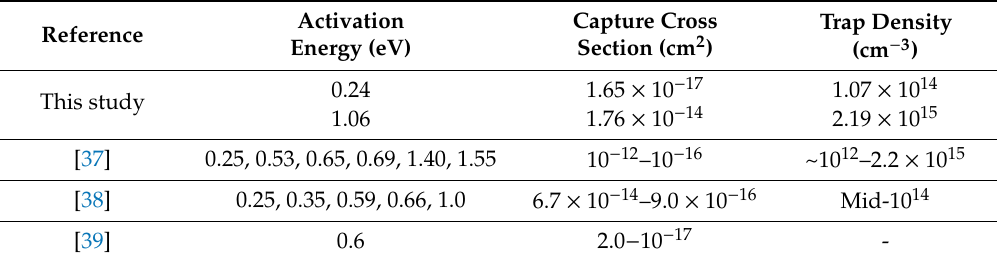
Figure 4. The DLTS spectra of Pd / Si-based GaN crystal Schottky diodes measured at the reverse voltage of − 2 V in the temperature range of 100–420 K and in the pulsing time of 100–500 ms. Table 1. The defect parameters for the Pd / Si-based FS-GaN Schottky diodes and their comparison to other